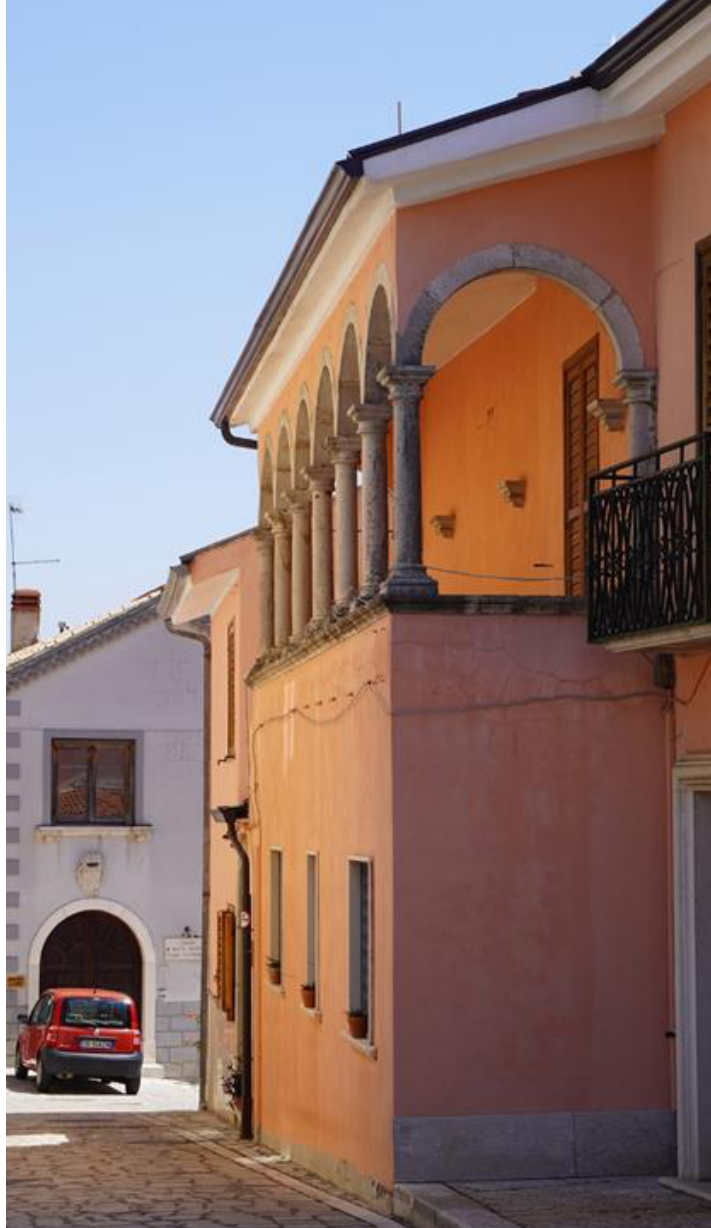
Figure 73. Guardia dei Lombardi: the restored historical centre (photos by [35,36]).